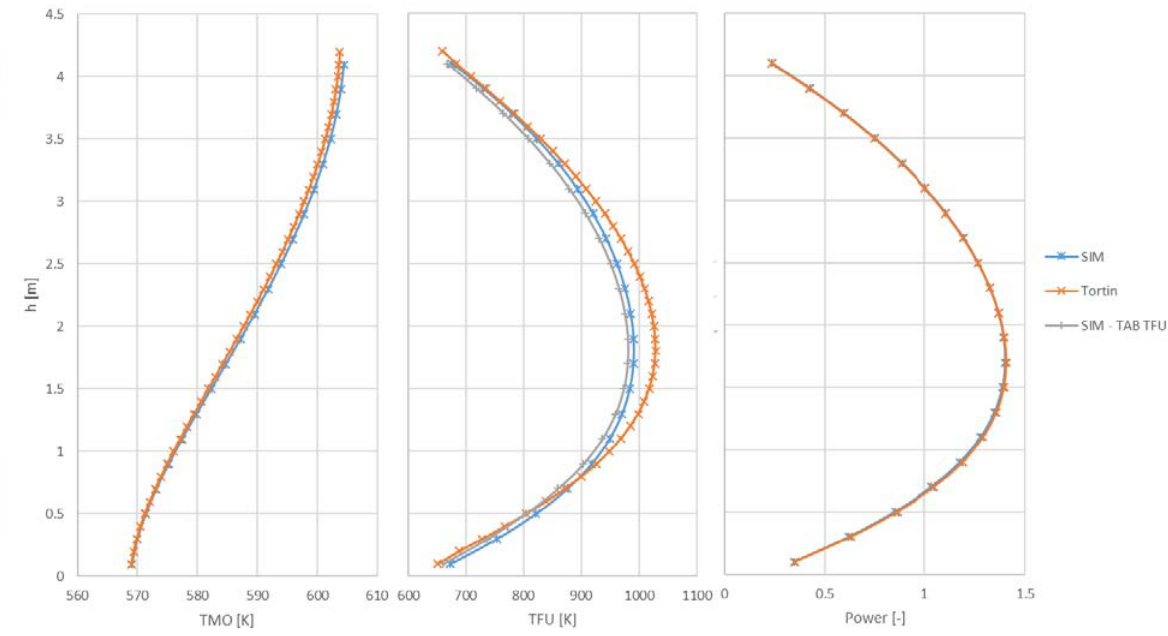
Figure 9. Moderator temperature, fuel temperature, and power – axial